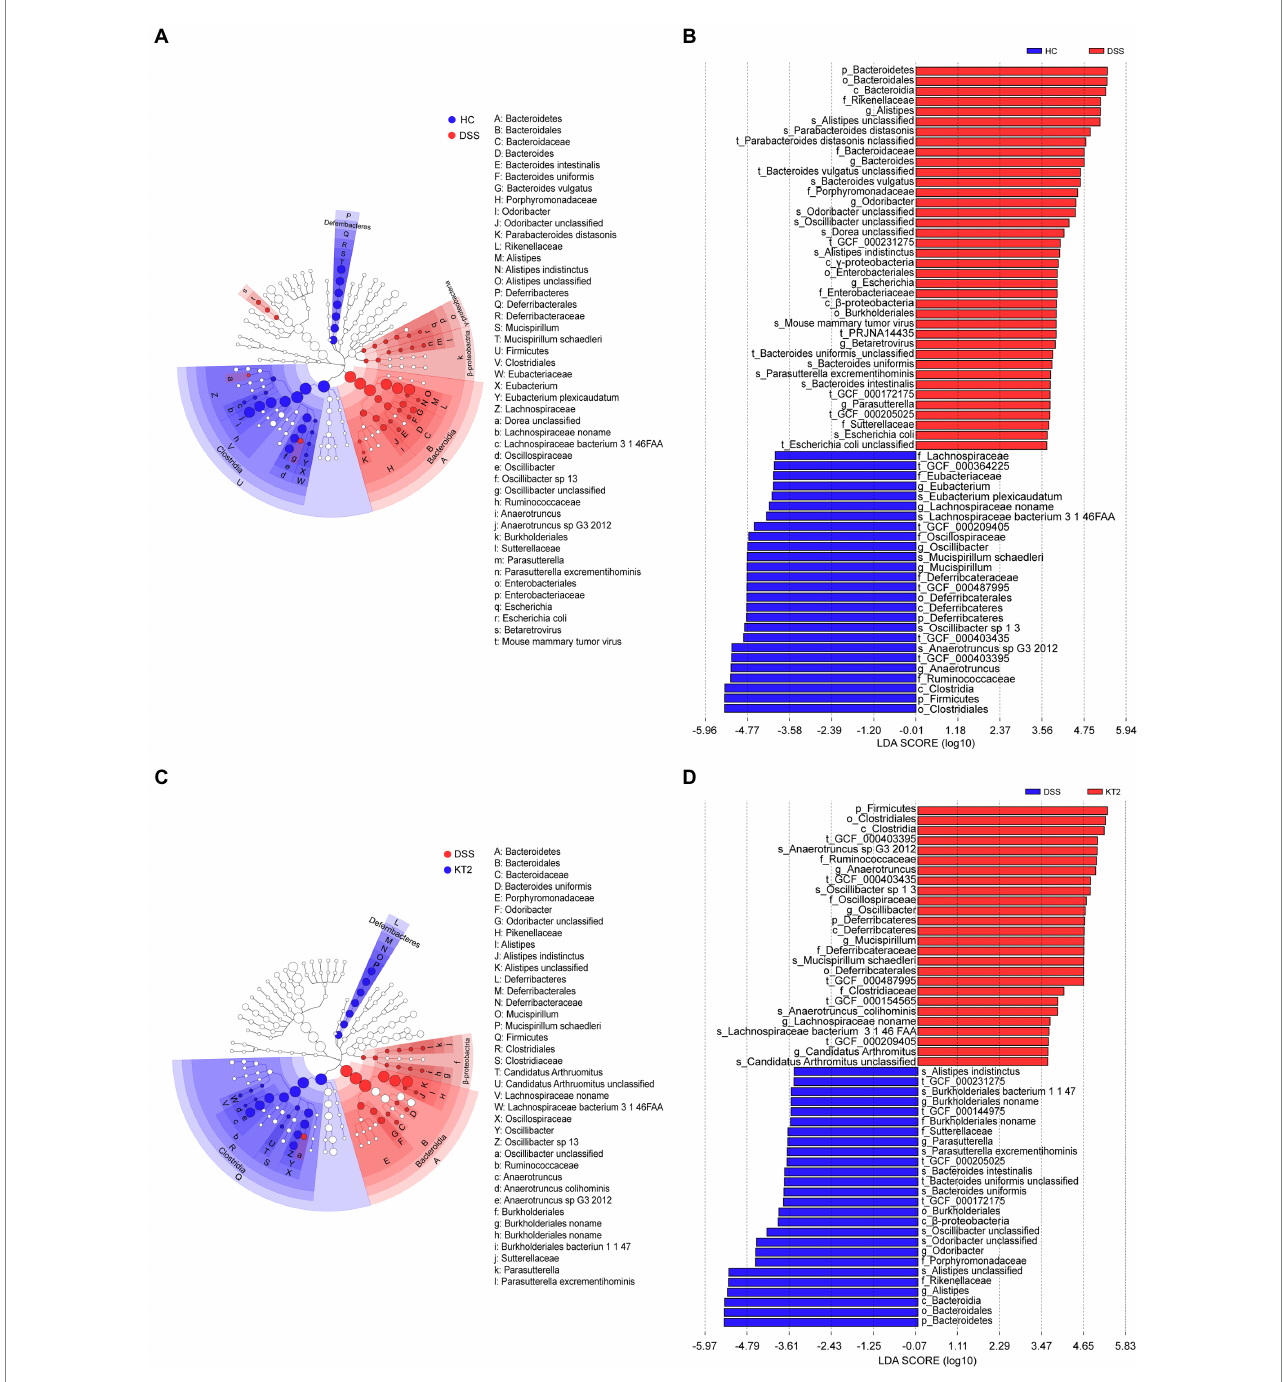
FIGURE 3 Linear discriminant analysis (LDA) effect size (LEfSe). (A, B) Cladogram indicating phylogenetic distribution of microbiota correlated with DSS and KT2 groups. (C, D) Differences in abundance between the DSS and KT2